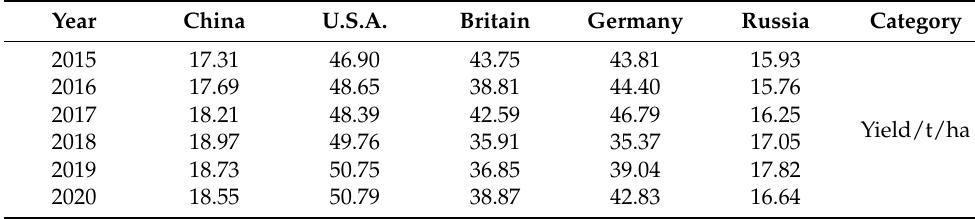
Table 2. Yield of potatoes in different countries. Date from reference [8]. Copyright 2022 FAO. Year China